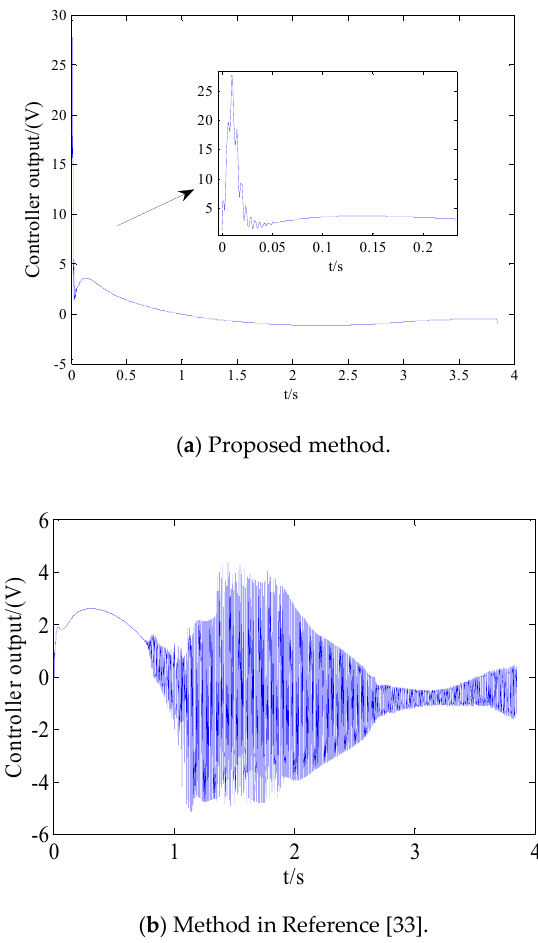
Figure 12. The controller output contrast.